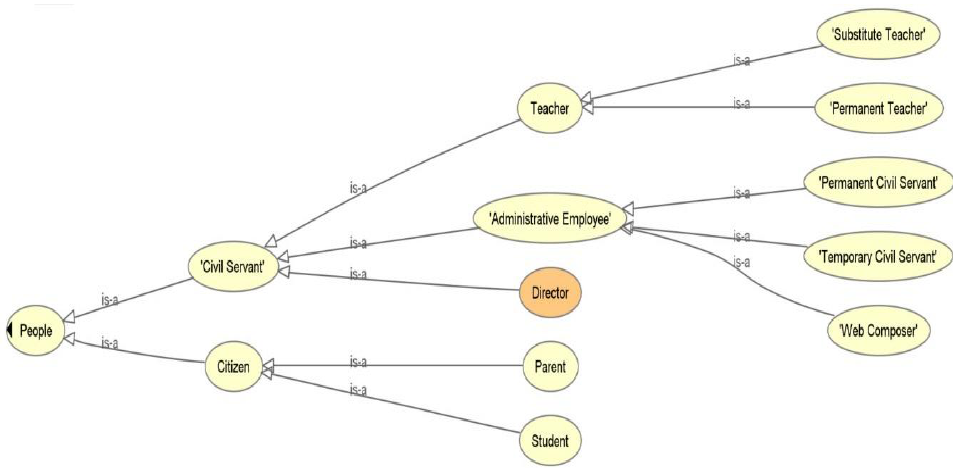
Figure 2. The People class hierarchy.